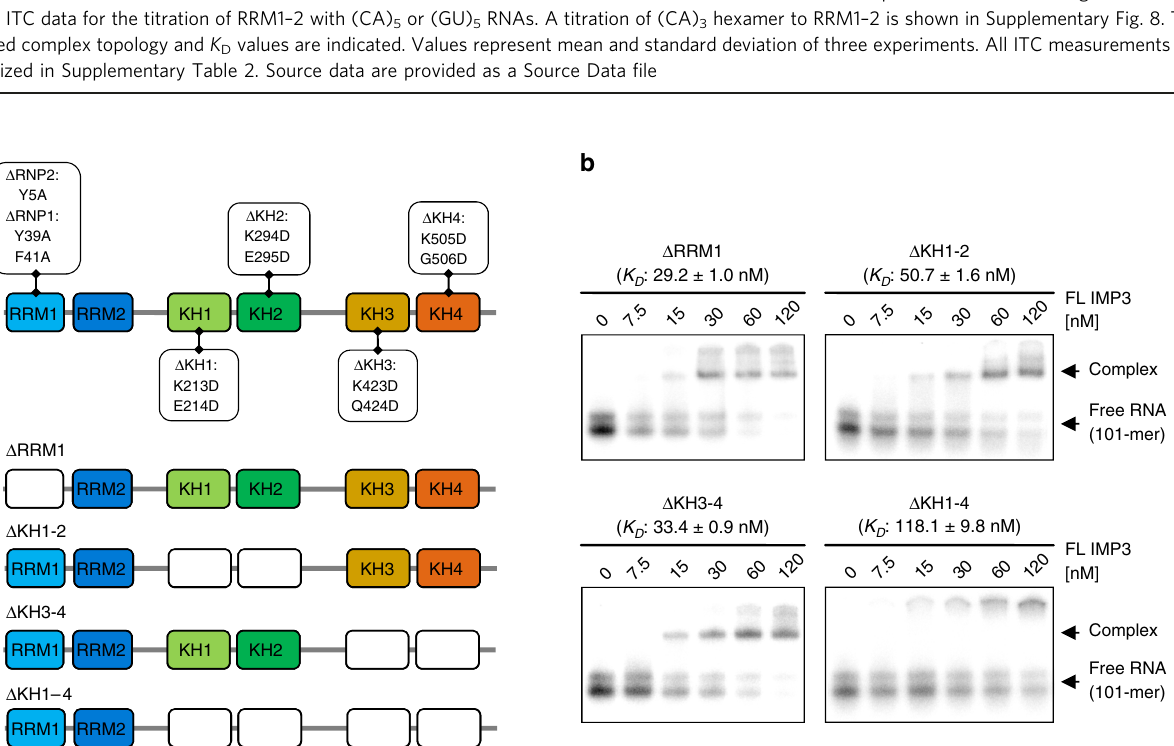
Fig. 6 Functional analysis of individual RNA-binding domains of IMP3. a Summary of mutations introduced in full-length IMP3 for functional analysis of individual RNA-binding domains (top) and schematic representation of the resulting mutants used for binding assays (bottom). RRM1 was inactivated by mutation of critical aromatic RNP residues, whereas the KH domains were inactivated by GxxG to GDDG conversion 30 . b EMSAs of the IMP3 mutants with the SELEX-derived 101-mer RNA (see Fig. 3a). Mutated IMP3 derivatives (0 – 120 nM) were titrated to a constant concentration of 32 P-labeled 101-mer RNA (5 nM, mean and standard error of three experiments). For the corresponding binding curves, see Supplementary Fig. 3. Source data are provided as